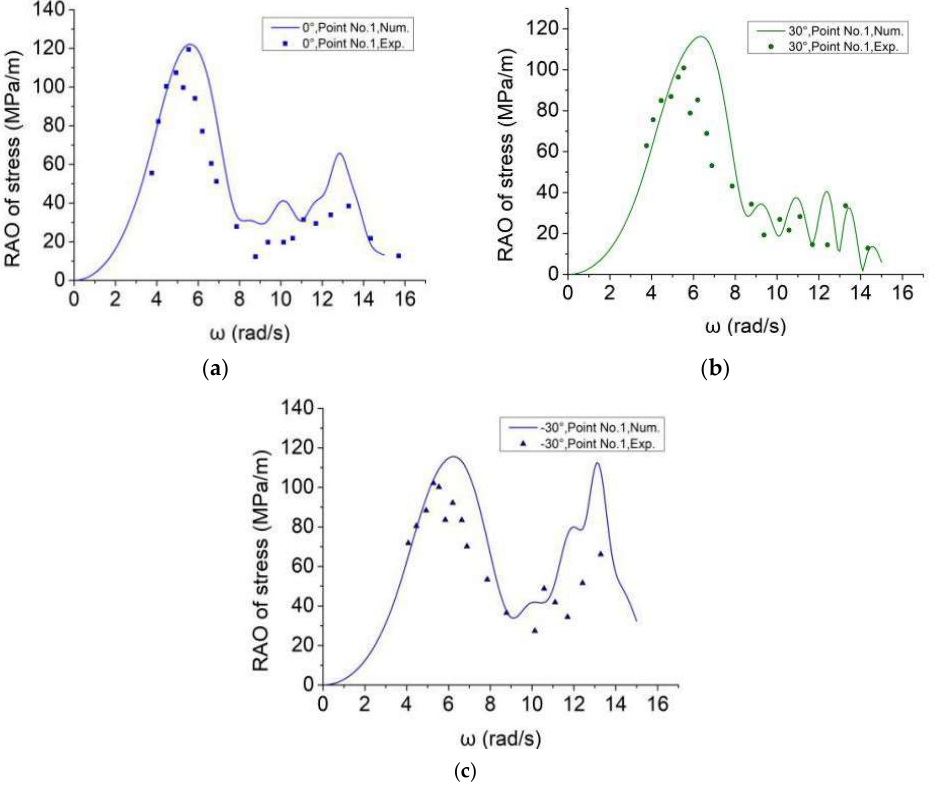
Figure 6. Frequency results of point 1. ( a ) Wave direction 0°. ( b ) Wave direction 30°. ( c ) Wave direction −30°.